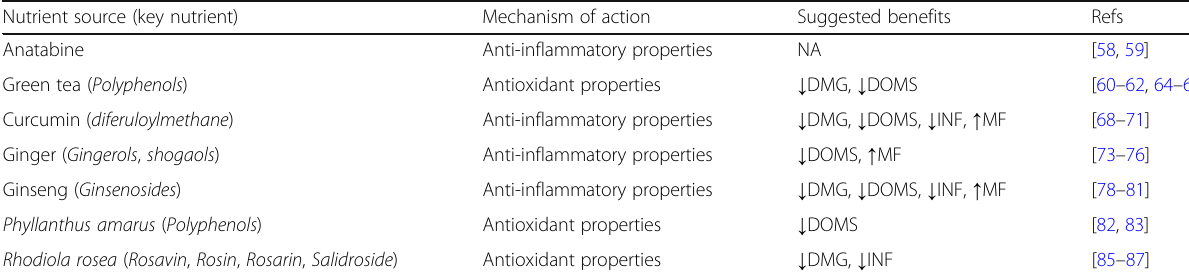
Table 3 Overview of herbs and herbal supplements Nutrient source (key